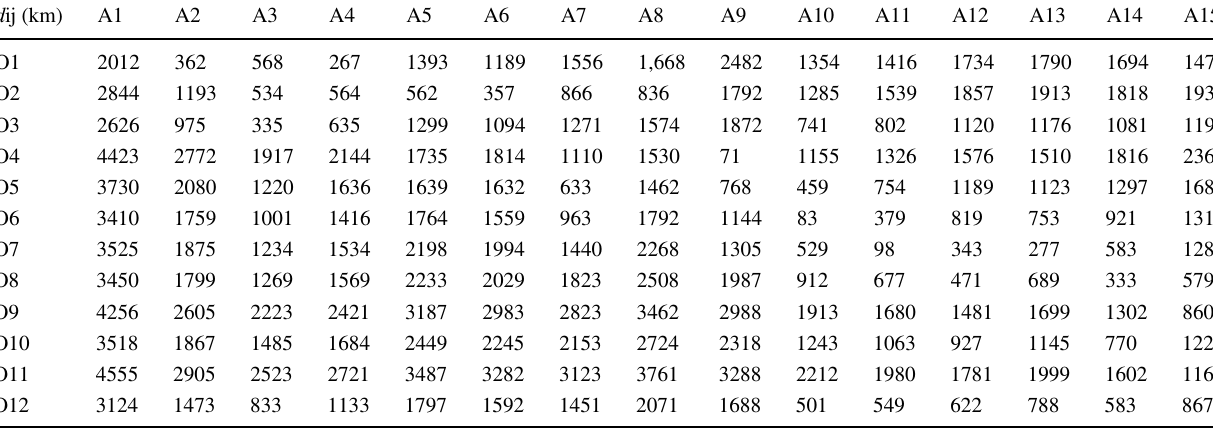
Table 7 The shortest distance from original reserve points to potential disaster-affected points d ij (km)